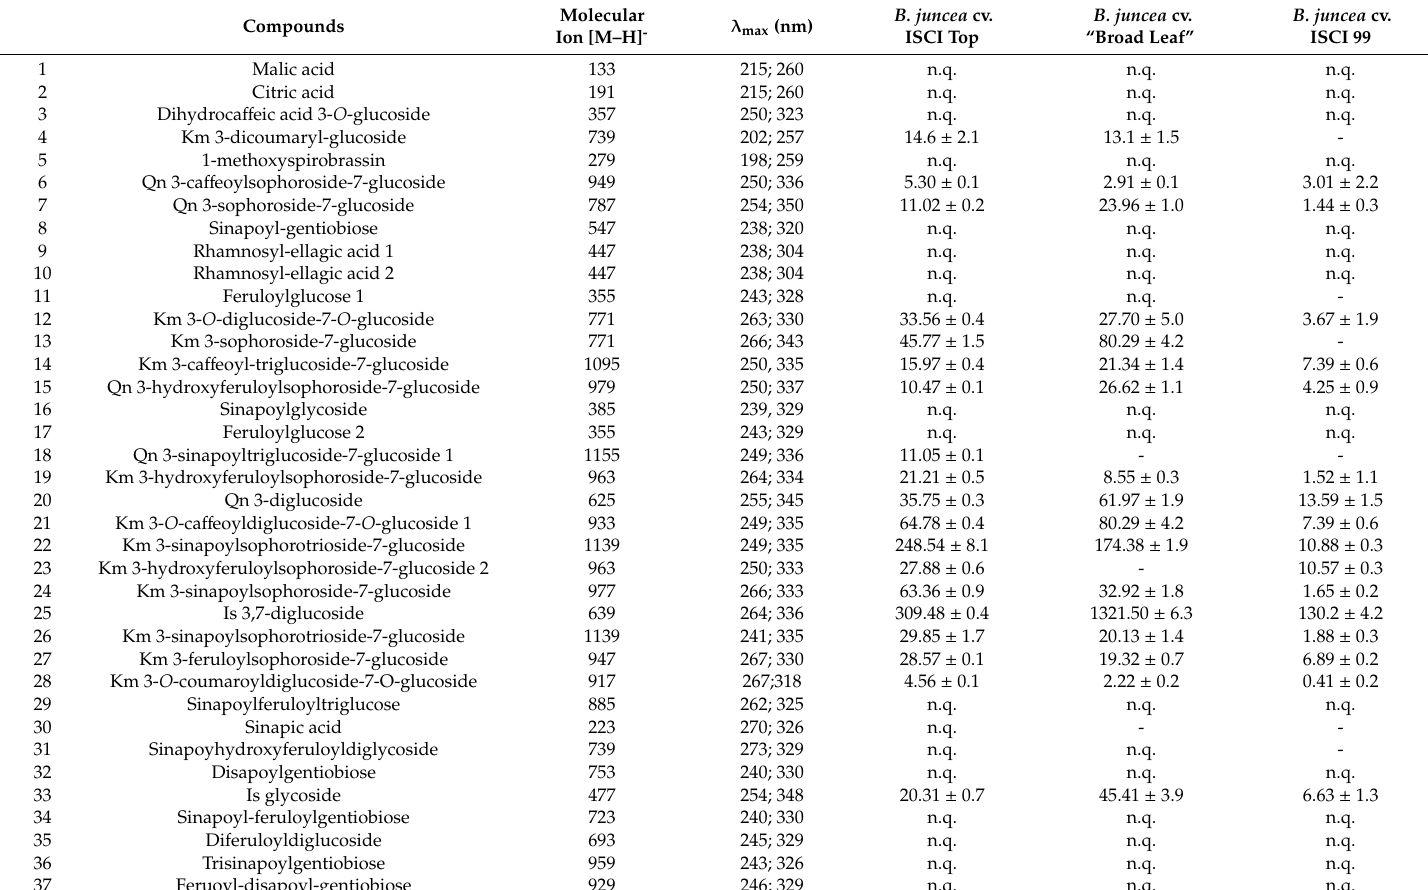
Table 3. Semi-quantitative analysis (mg / kg) of the flavonoid content of Brassica spp extracts. Results are expressed as mean ± S.D. of three replicates. Molecular λ max Compounds Ion [M–H] -